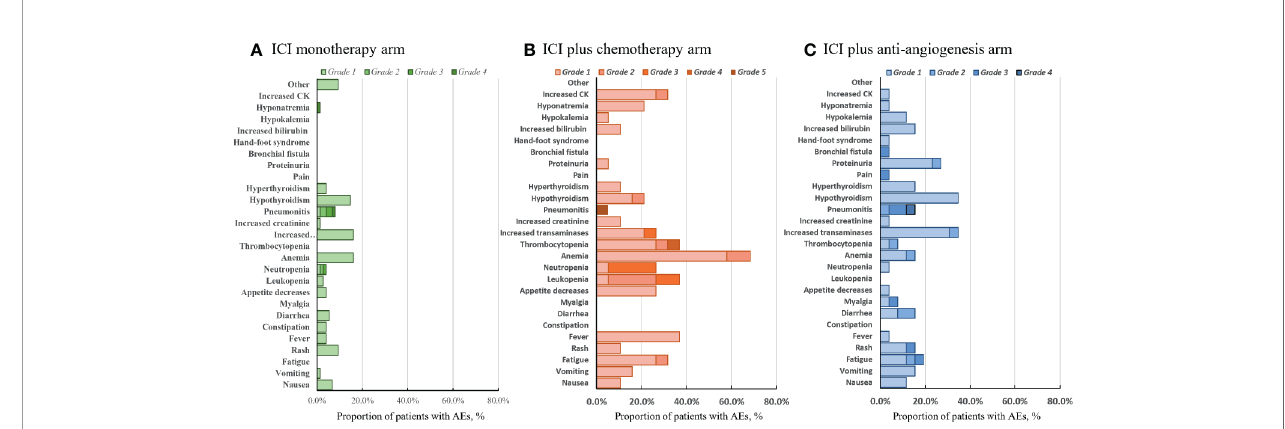
FIGURE 4 | Adverse events. All-cause adverse events of grades 1 – 5 in the ICI monotherapy (A) , ICI plus chemotherapy (B) , and ICI plus anti-angiogenic agent (C) groups. The color intensity re fl